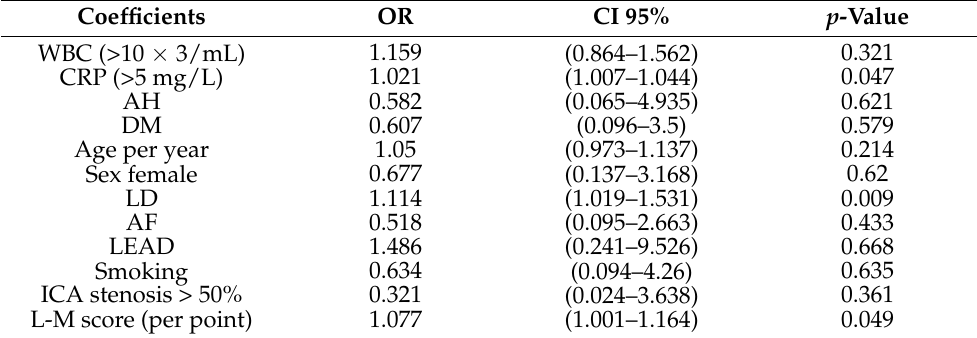
Table 3. The results of logistic regression analysis: the factors affecting the patients’ clinical status (NIHSS ≥ 7 points) on day seven after